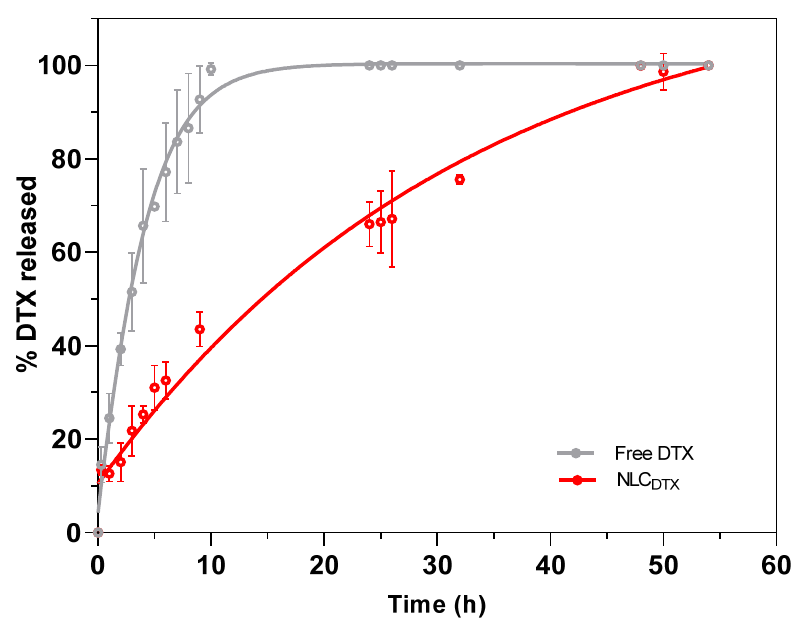
Figure 6. In vitro release kinetics of free or encapsulated DTX (NLC DTX ) determined at 37 °C, with a receptor medium composed of PBS: ethanol: Tween 80 (80:15:5%, v / v ), n = 3.